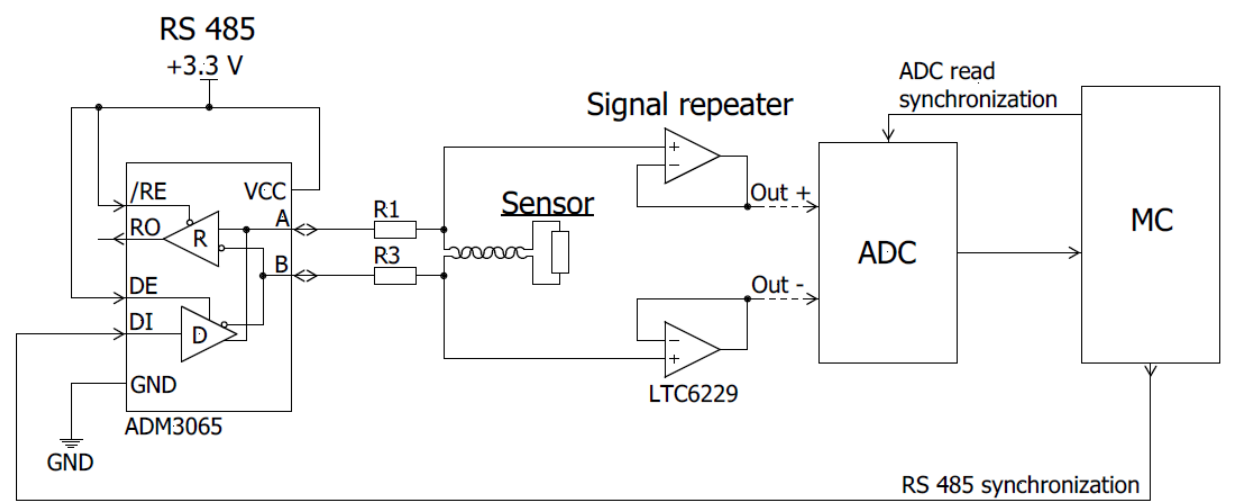
Figure 10. Circuit diagram of the sensor supply and digitalization of output signal.